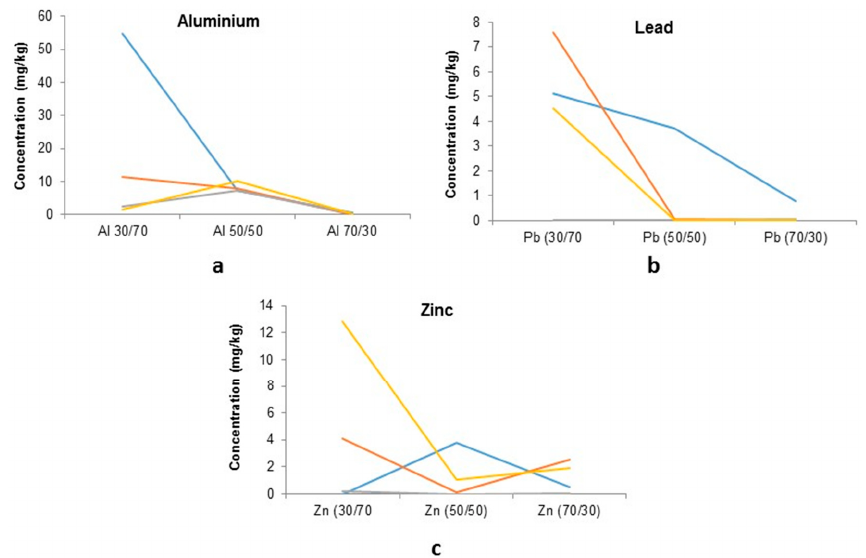
Figure 7. Total leached PTE concentrations from stabilised BF sludge and BF Slag: ( a ) Al; ( b ) Pb; and ( c ) Zn—different colours represent four different samples from the blast furnace.